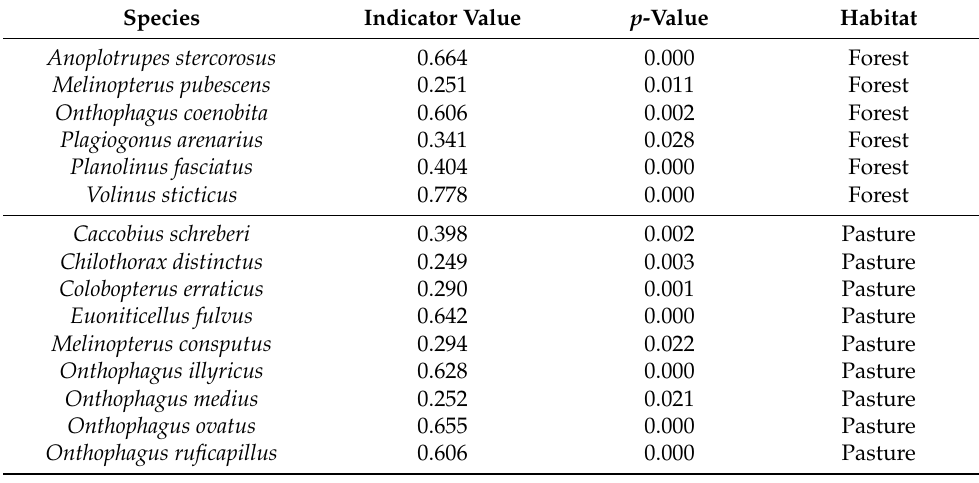
Table 1. Dung beetle species with significant indicator values for habitat, dung type, and